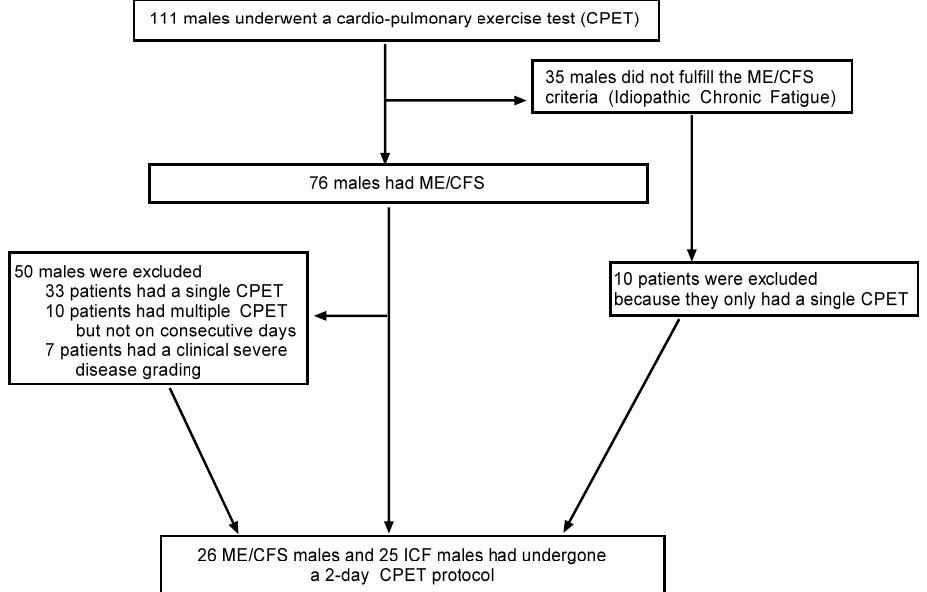
Figure A1. Patient flow. Legend figure: CPET: cardiopulmonary exercise test; ME/CFS: myalgic encephalomyelitis/chronic fatigue syndrome; ICF: idiopathic chronic fatigue.